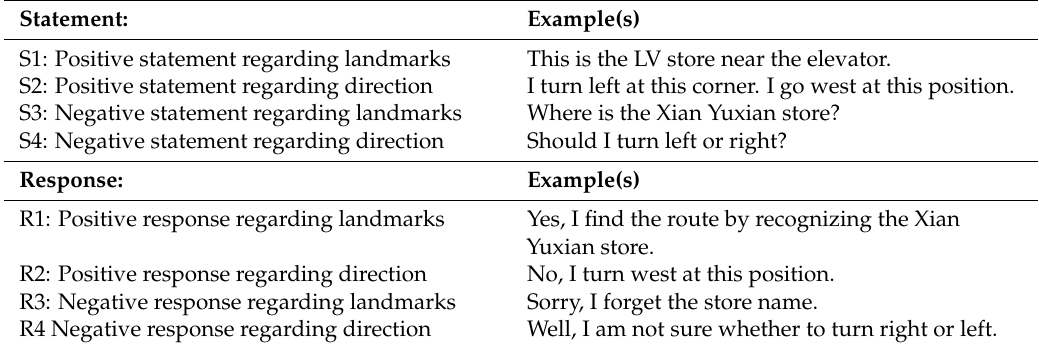
Table 9. Sentence classification for the verbal interaction between participants and researchers.